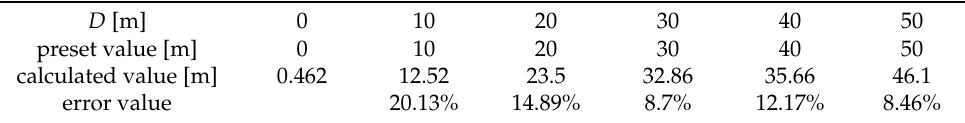
Table 1. Localization results in the y -direction for different distance abeams.